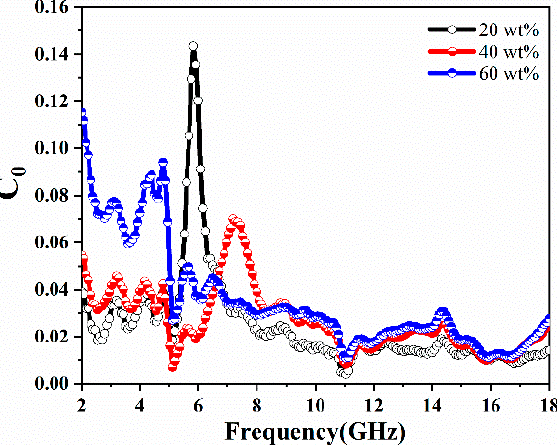
Figure 7. Eddy current loss (denoted by C 0 ) with frequency for CIP@MnO 2 composites with different filling ratios.